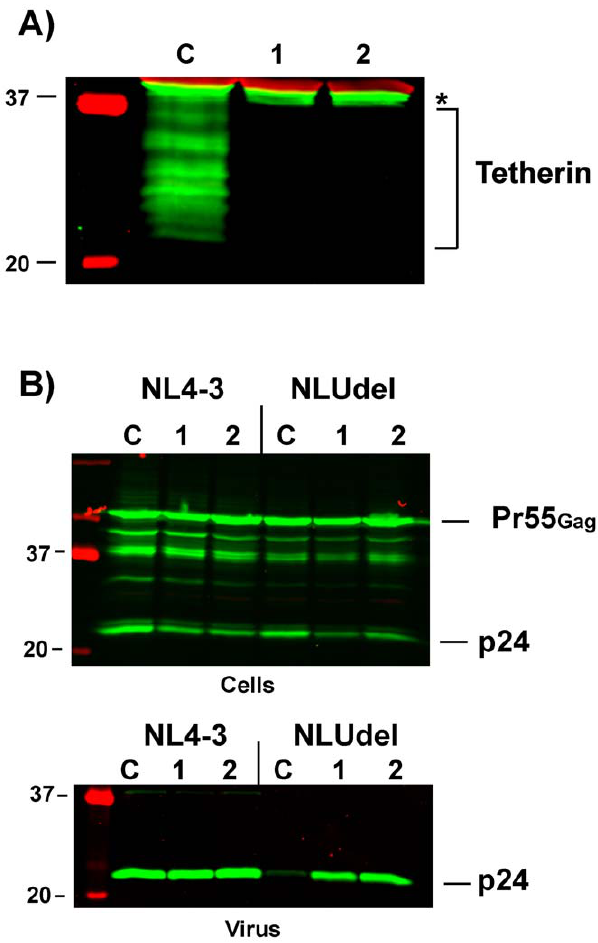
Figure 5. Tetherin depletion alone rescues particle release in HeLa cells. A) Two independently-derived knockdown cell populations (labeled 1,2) were employed in which knockdown of endogenous tetherin was nearly complete. Asterisk indicates a background band present in all lanes. B) Particle release defect in control shRNA- transduced HeLa cells (C) vs. knockdown cells (1, 2) is shown. Particle release was inhibited in control cells expressing NLUdel virus, while both knockdown cell populations restored particle release (NLUdel, 1 and 2 vs. C).